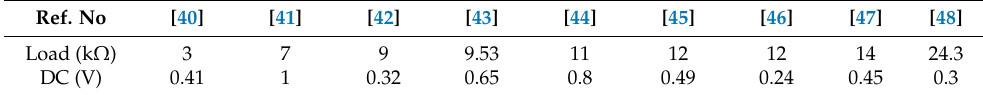
Table 4. Typical harvesters generated dc voltage for the corresponding